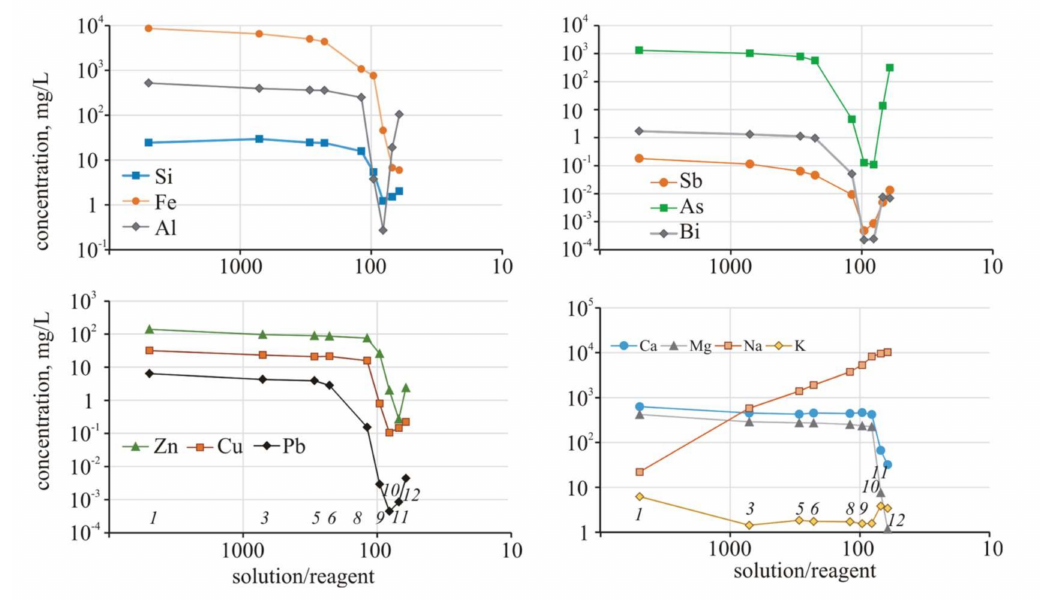
Figure 9. Changes in the element concentrations during the experiment with NaOH.